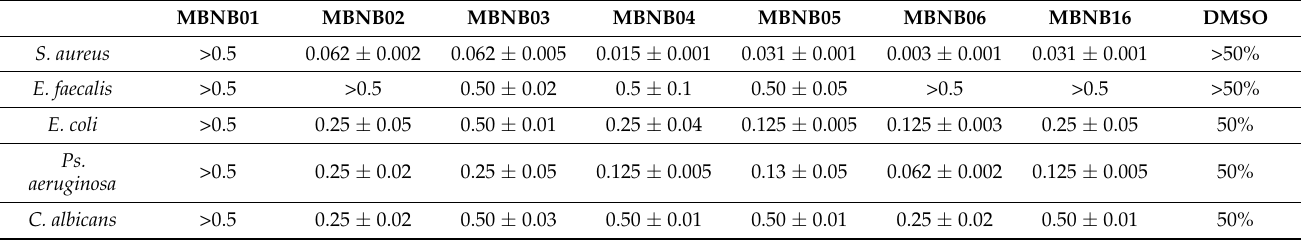
Table 2. Minimal Inhibitory Concentrations (MIC) of the samples expressed in mg/mL for the different microbial strains. Data are reported as mean ± SD.